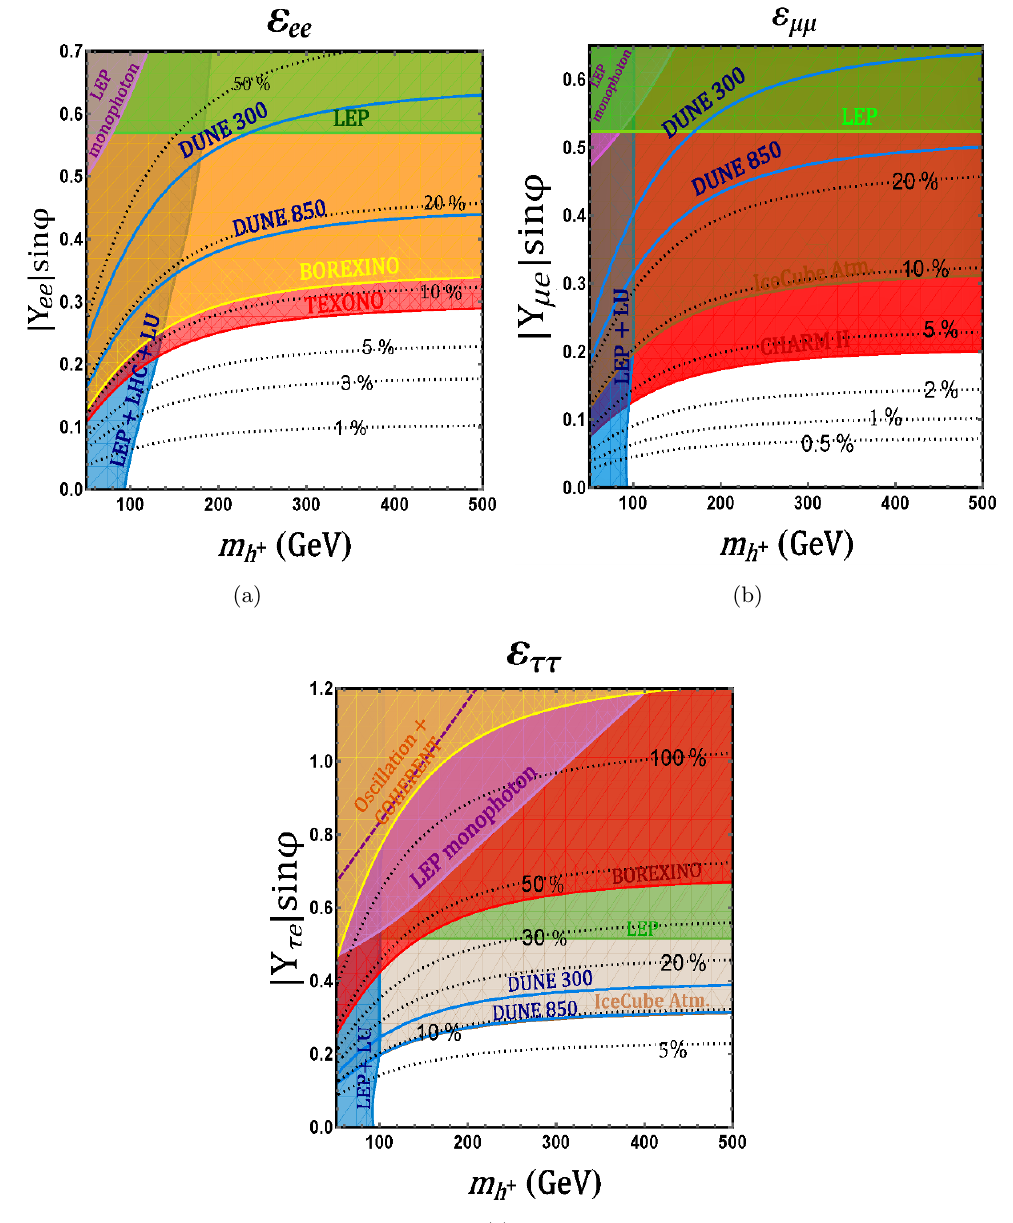
Figure 20 . Zee model predictions for diagonal NSI for light neutral scalar case. Here we have chosen m = 130 GeV. Labeling of the color-shaded regions is the same as in (cid:12)gure 18, except H + for the LEP dilepton constraint (green-shaded region) which replaces the T -parameter, CBM and LHC Higgs constraints.